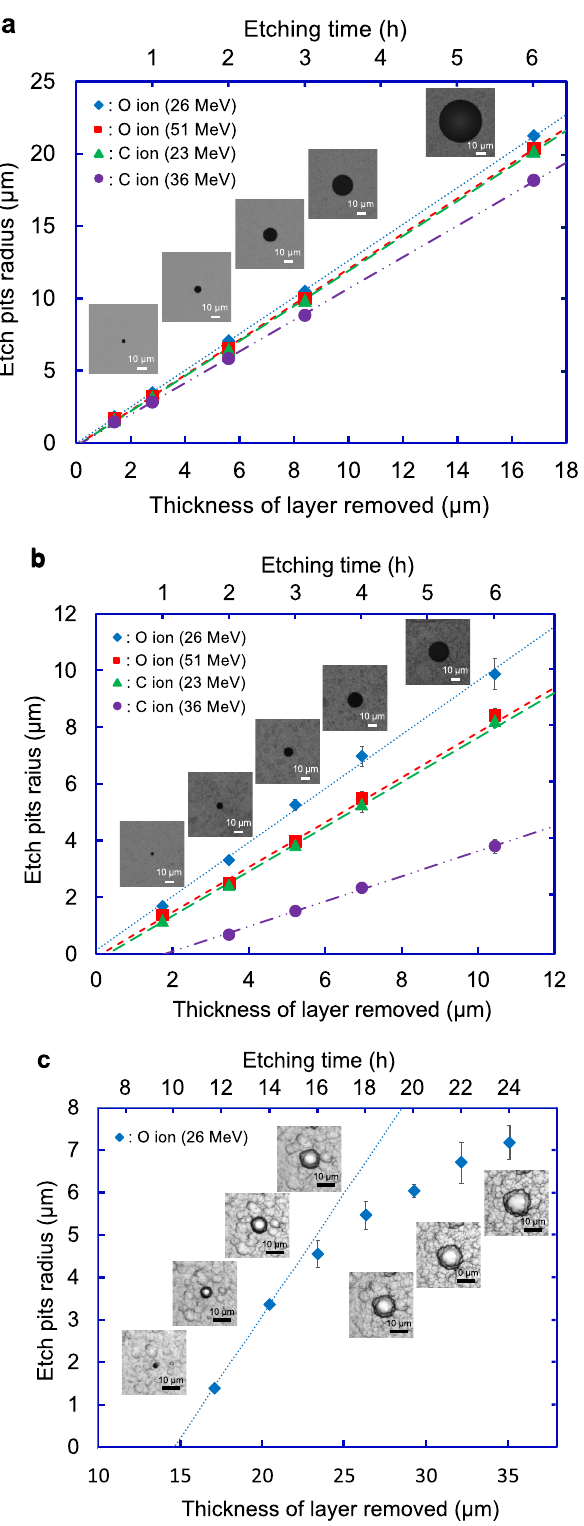
Figure 1. Etch pit growth curves of carbon and/or oxygen ions in ( a ) CR-39, ( b ) PC, and ( c ) PET. The inserted microscope images in ( a )–( c ) show etch pits of the 26 MeV oxygen ion registered on the front surface of each SSNTD at each etching time. The error bars represent the standard deviations of the etch pit radius. Some error bars are behind the